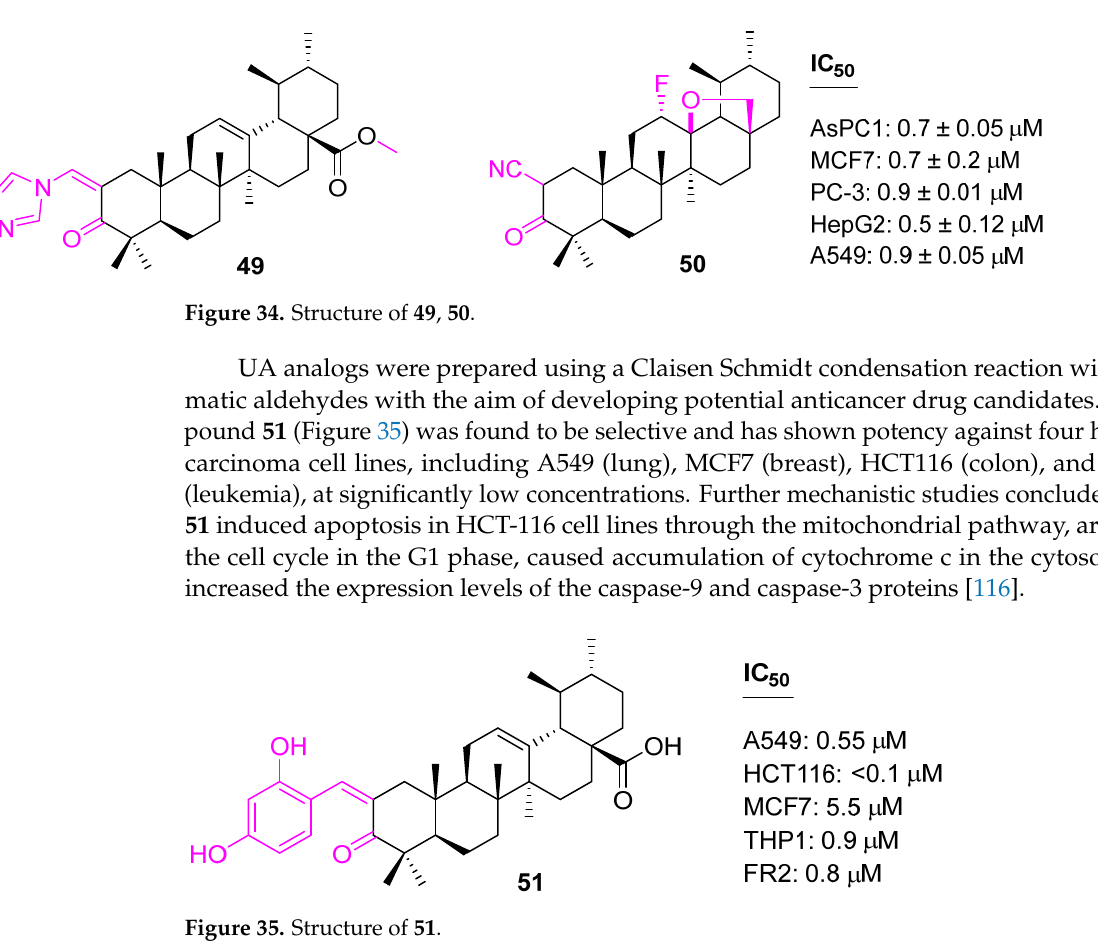
Figure 36. Structure of 52 , 53 . Similarly, Wang et al. synthesized a set of 2-amino-4-aryl-pyrimidine derivatives of UA and tested their anticancer potential against MCF7 and Hela cells. Compound 53 showed IC 50 values of 0.48 ± 0.11 and 0.74 ± 0.13 mM for MCF7 and Hela cells, respectively, and significantly low cytotoxicity to LO2 cells. A further molecular mechanistic study re- vealed that compound 53 inhibits cell migration, induces cell cycle arrest at the S phase, and triggers mitochondrial-related apoptosis by increasing the generation of intracellular ROS and decreasing the mitochondrial membrane potential (MMP). In addition, it partic- ipates in the up-regulation of the protein expression level of Bax and the downregulation of the level of Bcl2. Furthermore, molecular docking indicates that MEK1 kinase could be one of the possible targets for 53 [118]. Gu et al. synthesized quinoline derivatives of UA and evaluated their in vitro cyto- toxicity against three human cancer cell lines (MDA-MB231, Hela, and SMMC7721). Com- pound 54 (Figure 37) was found to be the most active one, with IC 50 values of 0.61 ± 0.07, 0.36 ± 0.05, 12.49 ± 0.08 μ M against MDA-MB231, Hela, and SMMC7721 cells, respectively, stronger than the positive control, etoposide. The mechanistic study by the Annexin V- FITC/PI dual staining assay confirmed that compound 54 induces the apoptosis of MDA- MB231 cells in a dose-dependent manner and arrests the cell cycle MDA-MB231 cells at the G0/G1 phase [119].